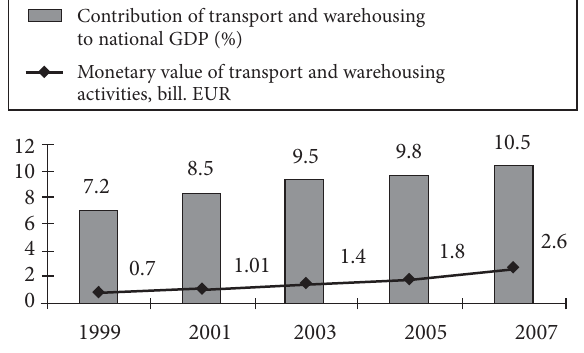
Fig. 2. Th e share of the transport sector to